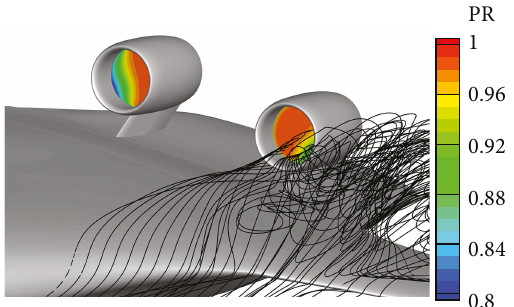
Figure 29: The in fl ow streamlines of the BWB300 at 13 ° (low